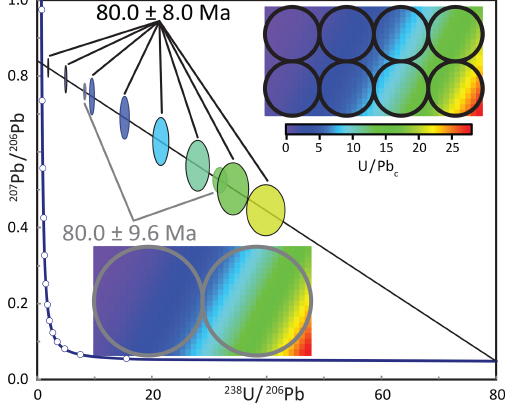
Figure 7. Tera–Wasserburg diagram representing the analysis of a heterogeneous medium using different spot sizes. Though the big- ger spot sizes yield smaller individual uncertainties, the smaller spots take advantage of the spread in U / Pb c ratios and thus yield a better overall uncertainty on the lower intercept